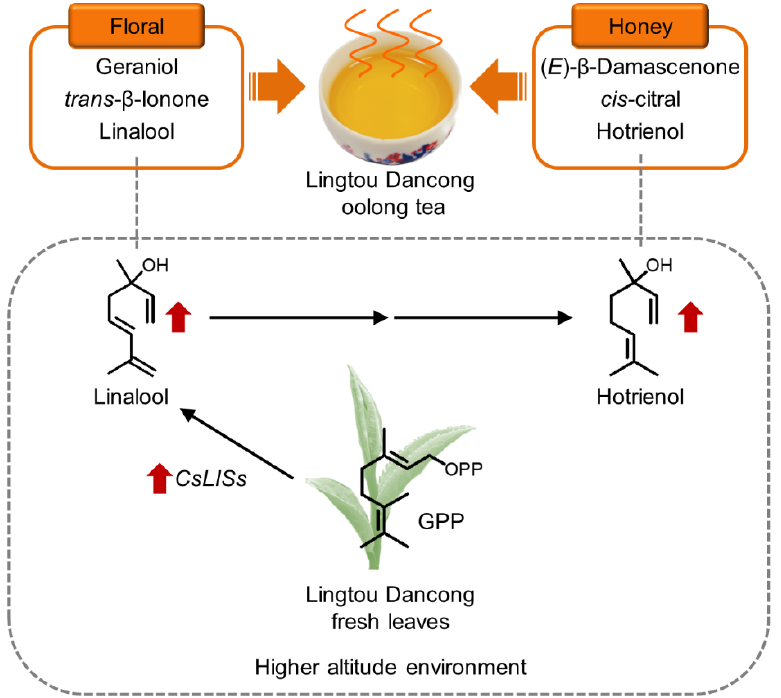
Figure 6. Aroma characteristics of Lingtou Dancong oolong tea and the effect of altitude on it. GPP, geranyl diphosphate; LIS , linalool synthase .